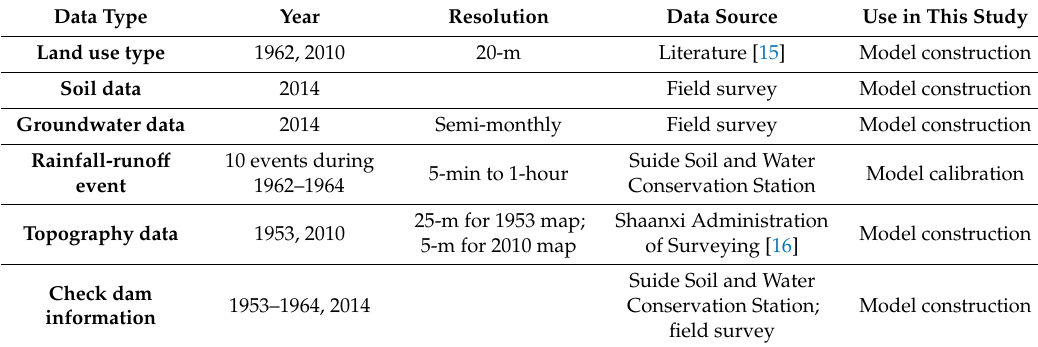
Figure 2. Landuse types of WMG catchment: ( a ) 1962; ( b ) 2010. The red dash line presents the boundary of GDG catchment. Table 1. Data set used in this study.